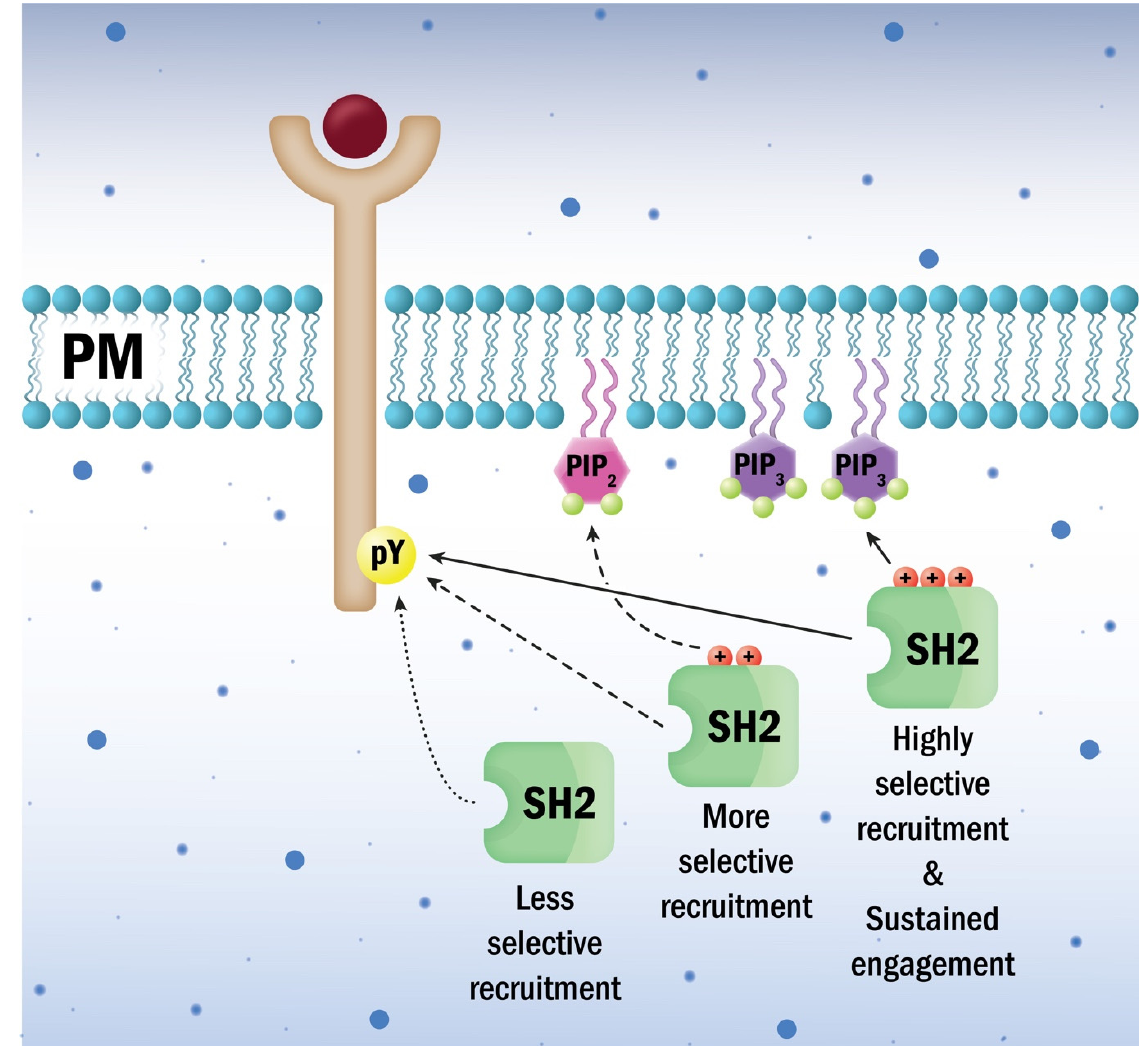
Figure 1. Lipid-binding abilities of some SH2 domains may contribute to spatio-temporal coordination of tyrosine kinase signaling hub dynamics. Alternative cationic patches distinct from the phosphotyrosine-binding pockets serve as the primary binding site for membrane lipids in most SH2 domains attracted to lipids. Phosphatidylinositol-4,5-bisphosphate or phosphatidylinositol-3,4,5-trisphosphate are preferred over other phosphoinositides for binding by these elements. The shape and net charge of the respective alternative cationic patches of specific SH2 domains provide further lipid recognition bias and may guide their host proteins to distinct membrane